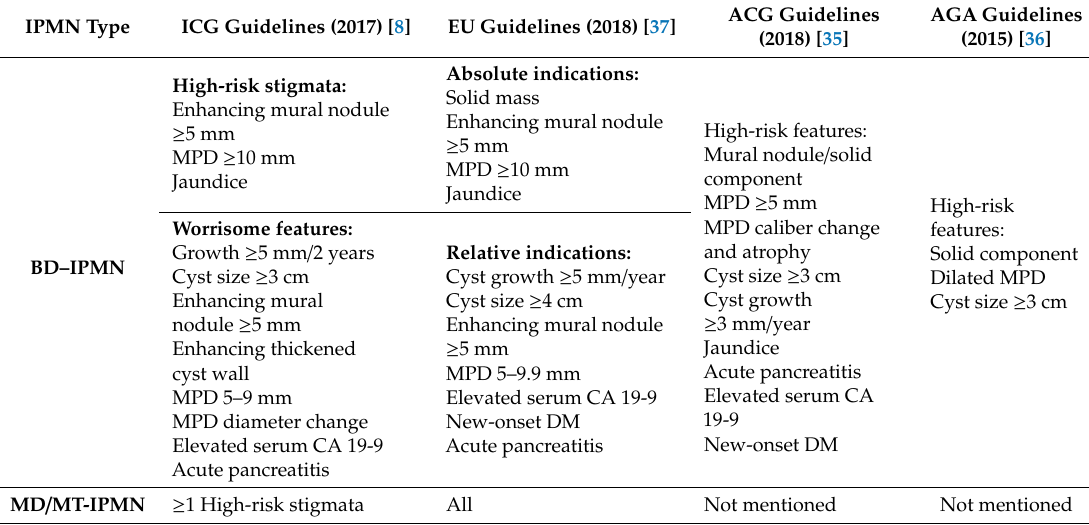
Table 4. Surgical indication for branch duct (BD), main duct (MD), and mixed type (MT)–IPMN according to most recent guidelines. IPMN: Intraductal papillary mucinous neoplasms; ICG: International Consensus Guidelines; EU: European Study Group on Cystic Tumors of the Pancreas; ACG, American College of Gastroenterology; AGA, American Gastroenterological Association; MPD: main pancreatic duct; CA 19-9: cancer antigen 19-9; DM: diabetes